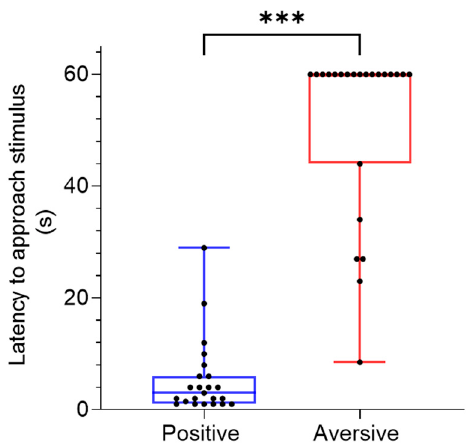
Figure 7. ( A ) Latency to approach (s) the positive stimulus during training weeks (1–10) in pigs ( n = 24), ( B ) indicates latency to approach aversive stimulus during training weeks (6–10) in pigs (n24). Data are medians with range. Significant difference is indicated with differences in subscripts ( p < 0.05).